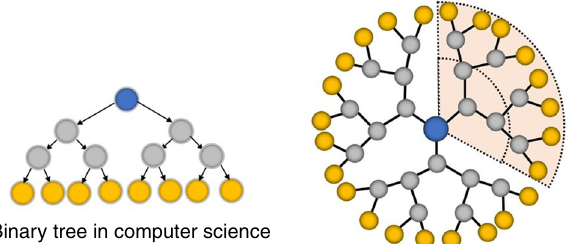
Fig. 1 Binary tree versus dendrimer. A typical binary-tree data structure in computer science and a dendrimer or dendron (marked with pale yellow background) structure in polymer science. Both of them have highly branched structures which result multi pathways from periphery to